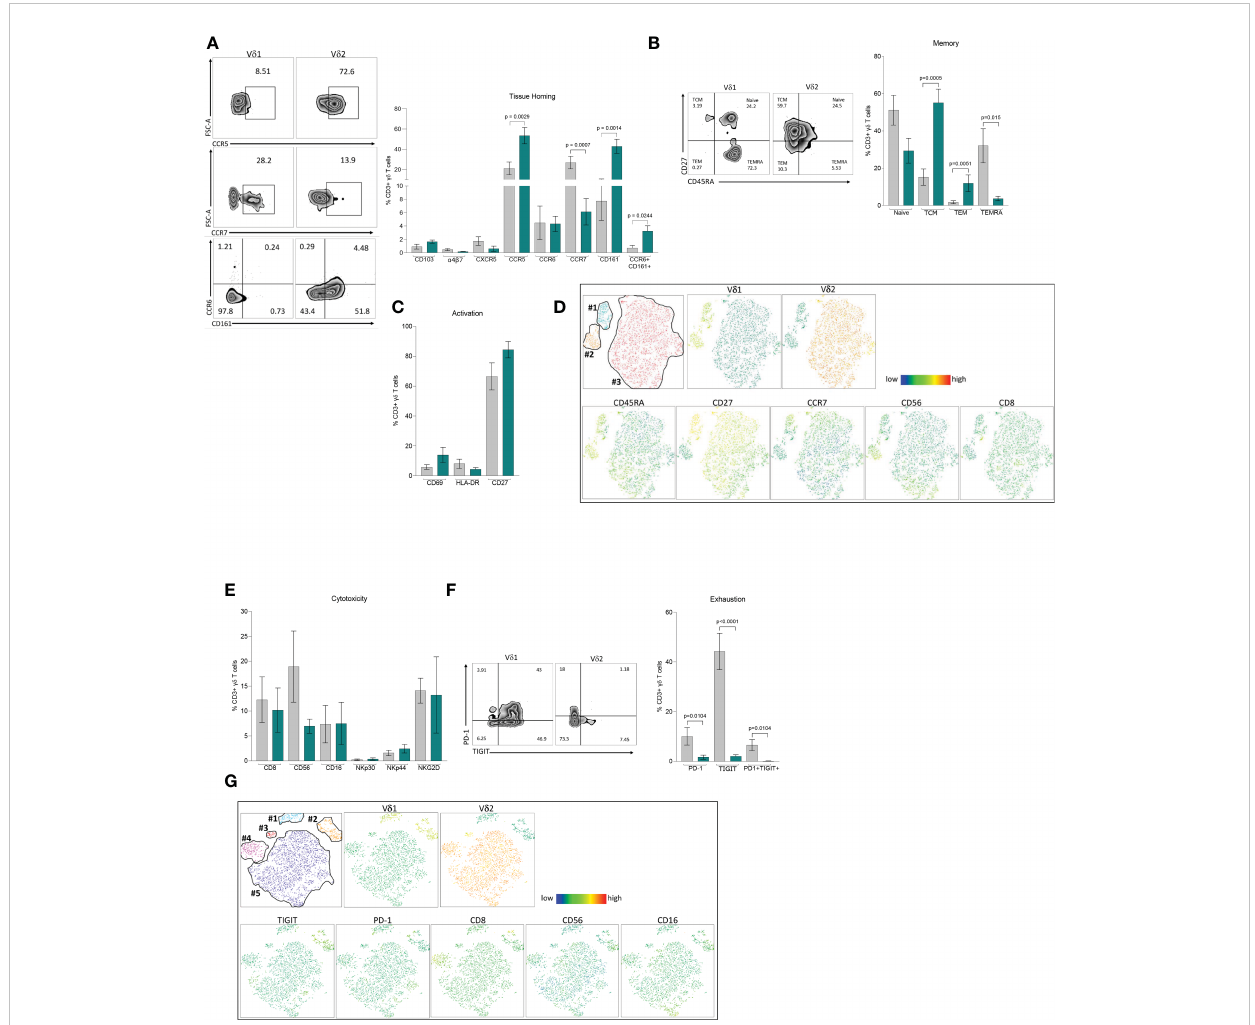
FIGURE 2 Phenotype of V d 1 and V d 2 T cells. Multiparametric fl ow cytometry in PBMCs from 11 healthy donor volunteers. (A) Tissue-homing receptors. (B) Memory populations de fi ned as Naïve (CD45RA+CD27+), TCM, central memory (CD45RA-CD27+), TEM, effector memory (CD45RA-CD27-) and TEMRA, (CD45RA+CD45+CD27-) (C) Activation markers, CD69, HLA-DR and CD27. (D) t-SNE analysis of memory markers based on V d 1 and V d 2 T cells. (E) Cytotoxicity markers CD8, CD56, CD16, NKp30, NKp44 and NKG2D. (F) Expression of immune exhaustion markers, PD-1, TIGIT and co- expression of PD1/TIGIT. (G) t-SNE analysis of cytotoxic markers based on V d 1 and V d 2 T cells expressing TIGIT. Mean ± SEM is shown; Mann- Whitney U test p-values < 0.05 are presented. V d 1 T cells are shown in grey and V d 2 T cells are shown in